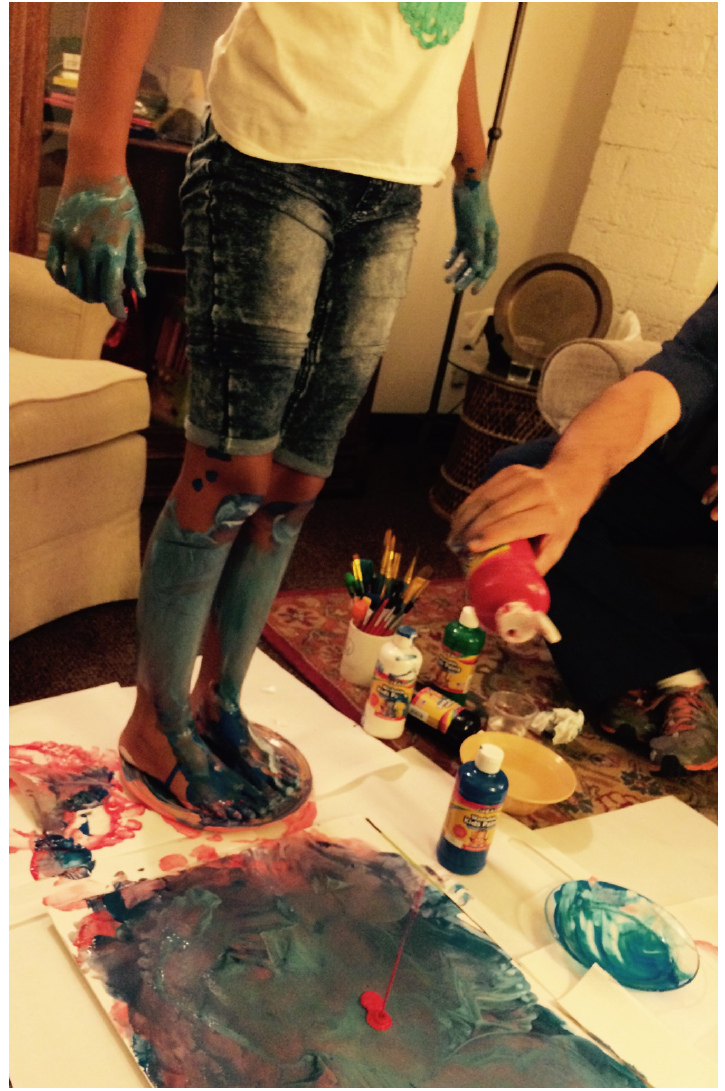
Figure 7Figure 7. Will my dad support my needs? Large sheets of paper, tempera paint. In both parental dyad sessions, a palpable process transpired. Elizabeth tried making messes first with me alone. When she saw that I supported her, she invited her mom to come closer to that part of herself with my negotiation. Correspondingly, after she tested my ability to keep her safe, but allow for free expression and less controlled materials, and give her the time and space she needed in the sessions, she invited dad to learn how to also support those